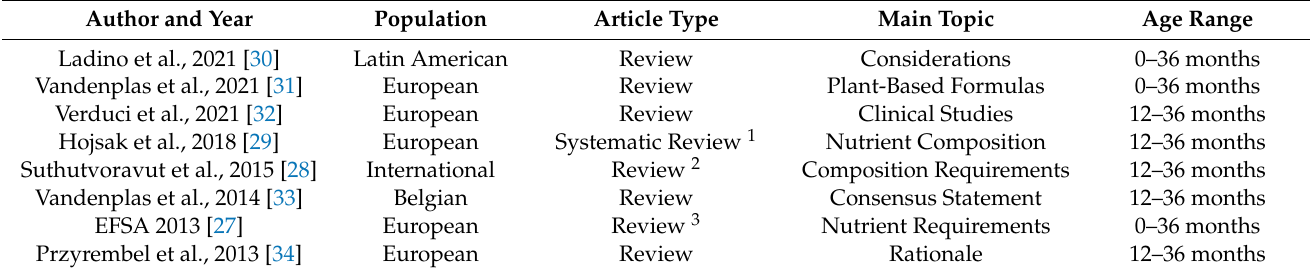
Table 1. Compositional Guidelines and Expert Statements of Young Child Formulas